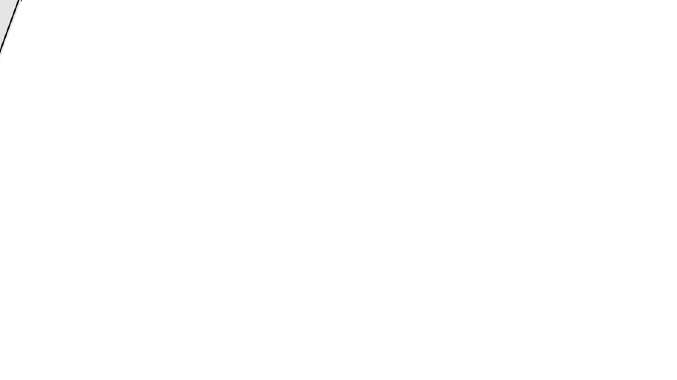
Figure 8. The velocity obstacle (VO) with a static obstacle. The green area represents the obstacle. The area surrounded by a dotted elliptical line is the obstacle domain. The area surrounded by a red elliptical line is the conflict position (ConfP).